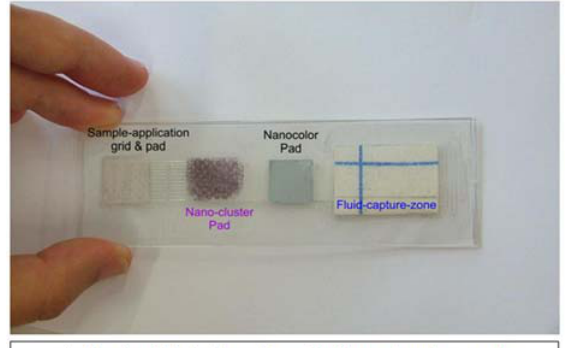
Figure 7. Setup of the laminated – laser-ablated fluidic